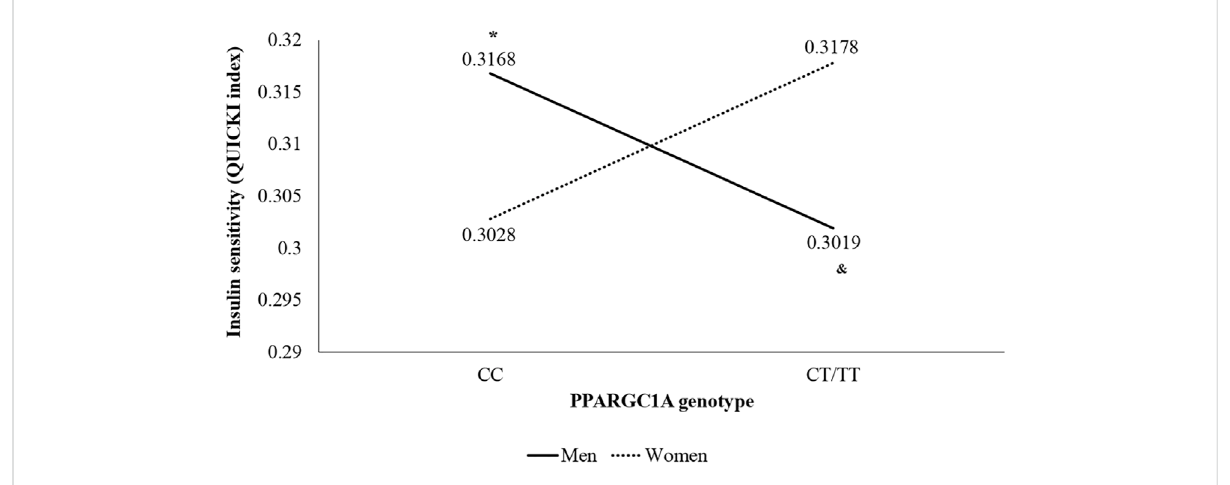
FIGURE 1 Interaction of sex and genotype of PPARGC1A gene rs8192678 C > T polymorphism in insulin sensitivity (QUICKI index) using the recessive model (CC vs. CT/TT). * p < 0.050 vs. other genotype groups. & p < 0.050 vs. women of the same genotype